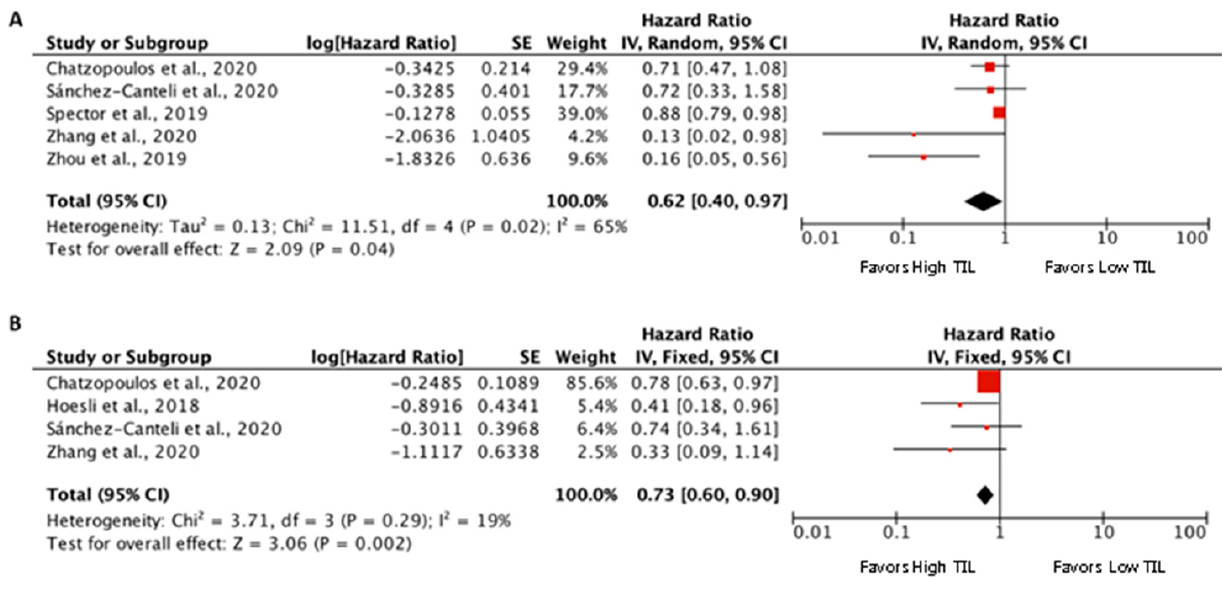
Figure 3. Forest plots of prognostic value of tumoral CD8+ TIL on overall survival ( A ) and disease-free survival ( B ). The prognostic value of CD4+ and/or CD3+ TIL was assessed in four eligible studies for inclusion in the meta-analysis [9,36,37,41] (Figure 4). The pooled meta-analysis showed an advantage for high CD4+ and/or CD3+ TIL (pooled HR 0.32 (95% CI 0.16–0.9), p = 0.03, for OS, and 0.23 (95% CI 0.10–0.53), p = 0.0005, for DFS). Again, the methods of evalu- ation were diverse. Two studies evaluated tumor-infiltrating CD4+ cells (CD4+ T cells counts/mm 2 of tumor area) dichotomized at the median [9,36], another study stromal- infiltrating CD3+ cells (CD3+ T cells counts/mm 2 of stromal area) dichotomized at the median [37], and in another study an Immunoscore higher or equal to 2 [41]. The potential for publication bias was assessed by the visual inspection of funnel plots, since the number of studies for each meta-analysis was too small (less than 10) to allow the use of tests for funnel plot asymmetry. As shown in Figure 5, funnel plot asymmetry was observed on the outcomes of OS and DFS for the different methods of evaluation of TIL, suggesting the existence of a publication bias that must be considered when interpreting the